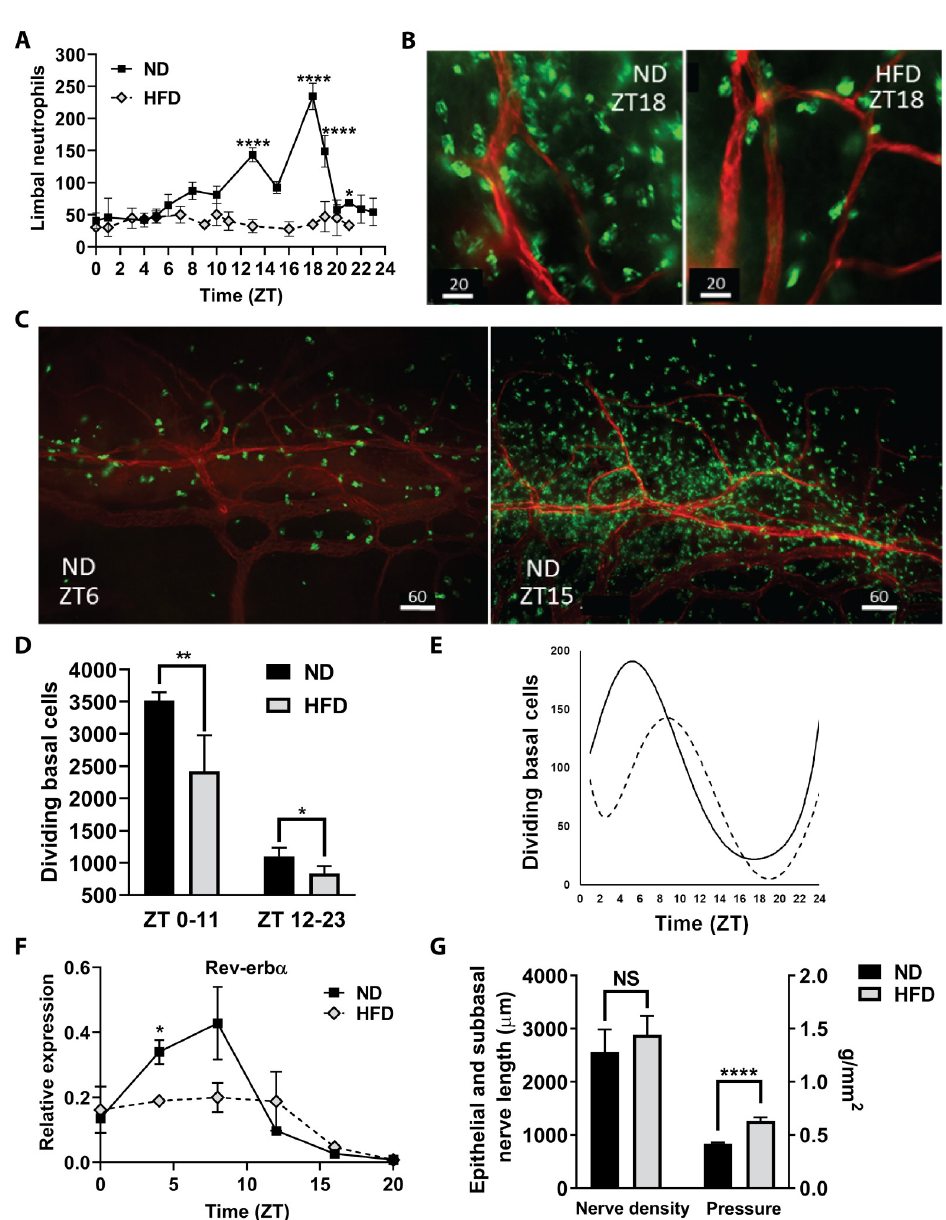
Fig 4. Corneal changes after 10 days on the high fat diet. (A) Neutrophils were counted in four 40X microscope fields of view in extravascular limbal tissue at intervals over a 24h cycle (n = 4 corneas per group at each time point). (B) Representative micrographs of neutrophils in the limbus at ZT18, comparing limbal regions of mice fed a ND and a HFD; neutrophils (green), limbal blood vessels (red), scale bar = 20 μ m. (C) Representative micrographs of neutrophils around the limbal vascular network at ZT6 and ZT15 in corneas from mice on ND; neutrophils (green), limbal blood vessels (red), scale bar = 60 μ m. (D) The average of the sum of mitotic cells observed in the basal epithelium in nine perpendicular (horizontal and vertical) 40X microscopic fields across the cornea from limbus to limbus between ZT0-ZT11 and ZT12-ZT23 (n = 4 corneas per group collected every hour for 24h). (E) Changes in the number of mitotic cells in corneal epithelial cells over a 24h cycle. A polynomial function was used to fit the curve for the dividing cell number (the average of the sum of mitotic cells counted in nine vertical and horizontal 40X fields at each time point) with n = 4 corneas collected every hour for 24h (ZT scale). Solid line = ND, dotted line = HFD. (F) Expression of clock gene Rev-erb α over a 24h cycle (n = 2 independent pooled samples from 6–8 mice at each time point). (G) Nerve density (total axon length ( μ m) of the epithelial branches and subbasal plexus) in the corneal epithelium of ND mice and HFD mice (n = 4 per group). Corneal sensitivity, measured as the tactile pressure (g/mm 2 ) required to elicit a blink, in mice fed the HFD for 10 days compared to ND fed mice (n = 6 per group). Data shown as means ± SD (A-E) and SEM (F, G). � p < 0.05, �� p < 0.01, ���� p < 0.0001.